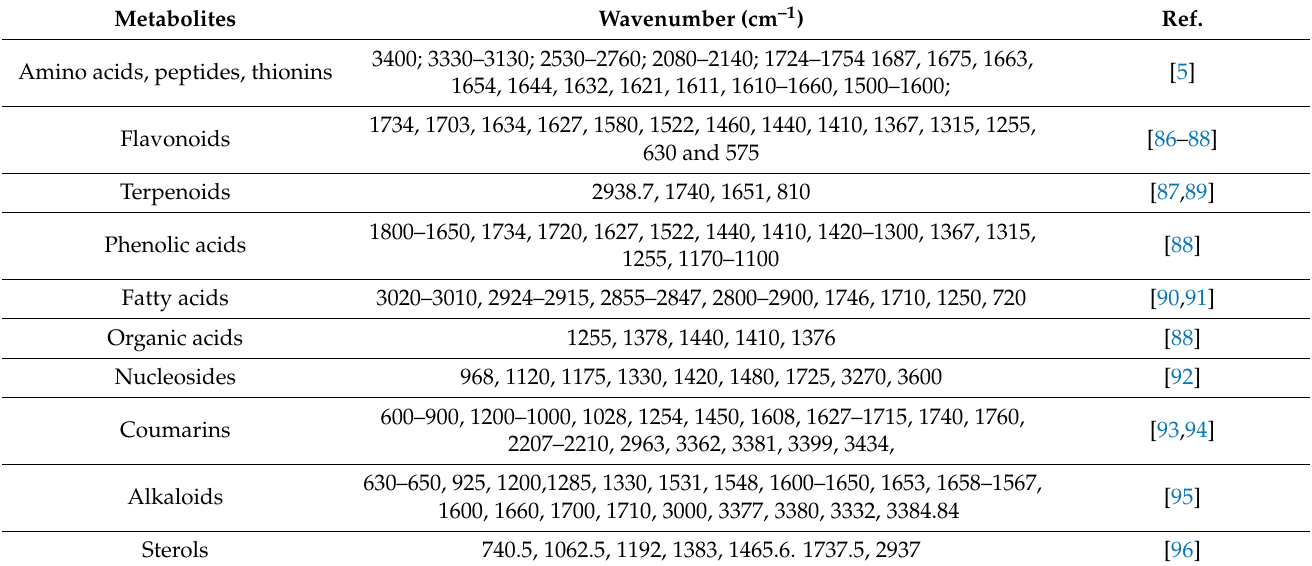
Figure 3. ( a ) FT-IR spectrum of the viscum sample and viscum–AuNPs carrier assembly; ( b ) FT-IR spectrum of AuNPs coated with trisodium citrate and the trisodium citrate spectrum. Table 3. The characteristic group frequencies attributed to different metabolites identified in Viscum album.